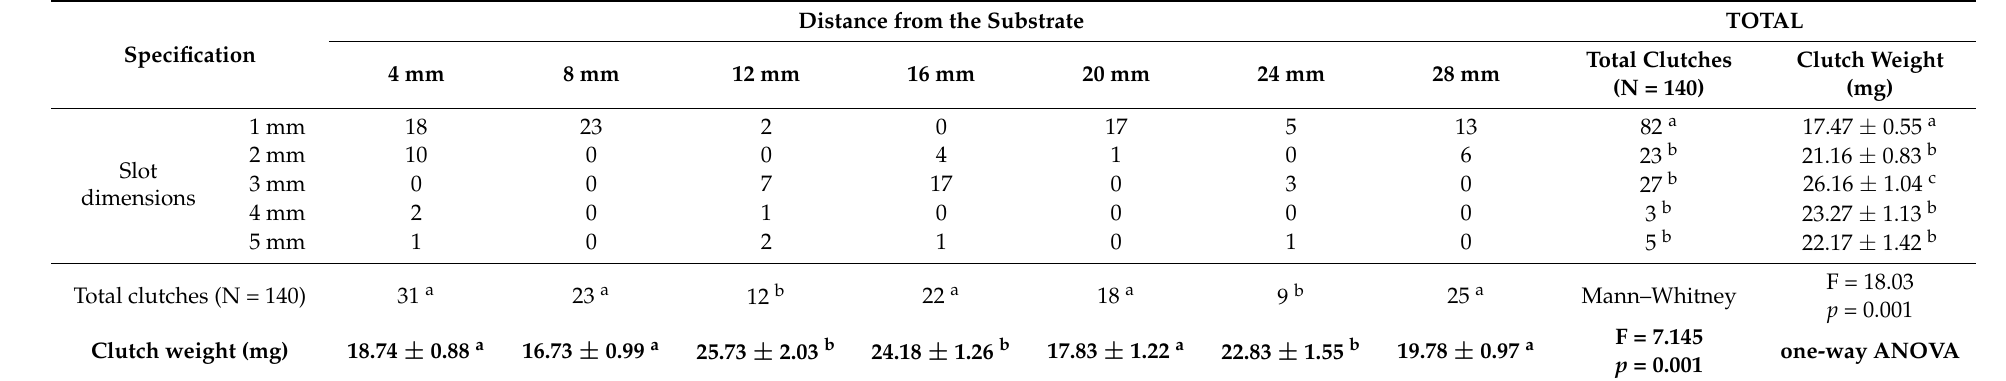
Table 1. Number and average weight of the clutches depending on the slot size and the distance from the attractive substrate.